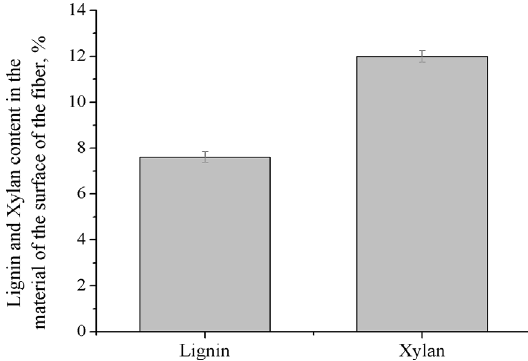
Figure 3. Lignin and xylan in the secondary fines (peeling) of the unbleached pulp.